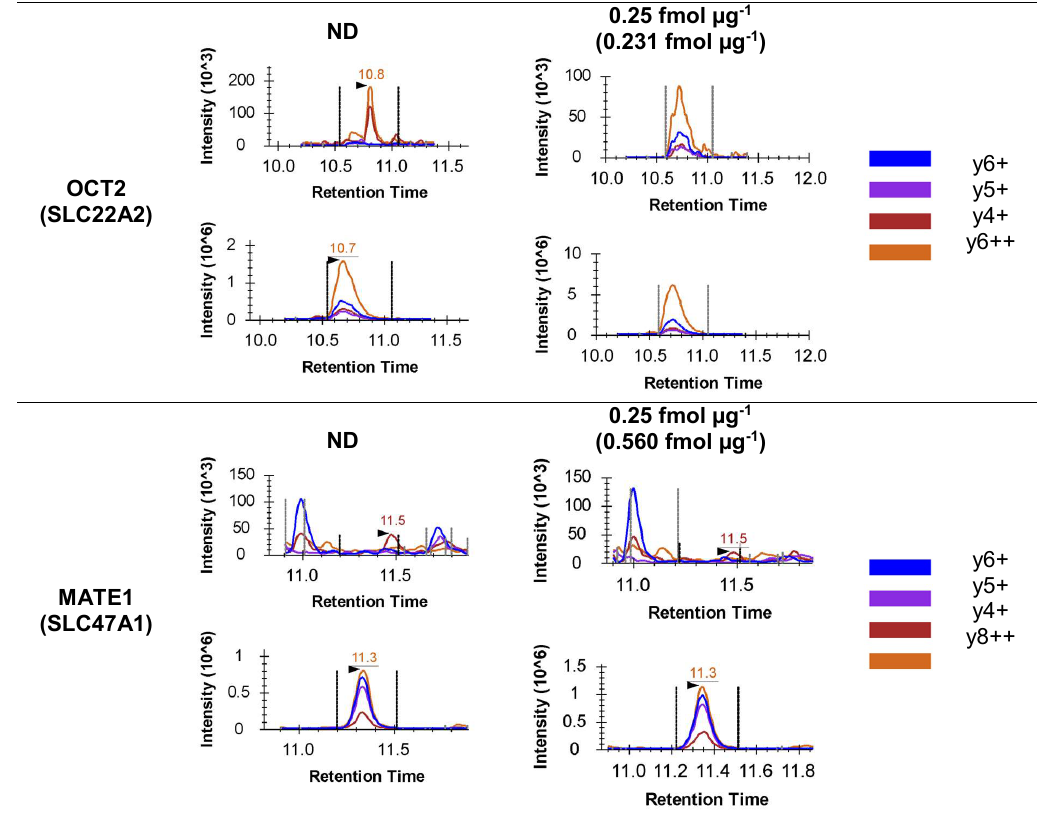
Figure 3. Representative chromatogram examples of the three quantified transporters OCT1 (SLC22A1), OCT2 (SLC22A2) and MATE1 (SLC47A1). The left column entitled “Vessels glioma3” shows the chromatograms obtained after analysis of the sample “Vessels glioma3”, for each of the proteins. In each box of this column, the top chromatogram is the one obtained after detection of the unlabeled peptide specific for the protein; the chromatogram at the bottom is the one obtained after detection of the labeled peptide. The absence of unlabeled peptide (therefore protein ND; not detected) is proven when there is no peak on the top chromatogram at the same retention time as the peak of the bottom chromatogram (case of OCT1, MATE1). For OCT2, the absence of the unlabeled peptide is proven because the peak at 10.8 min (top chromatogram) is the one obtained for a molecule which does not have the same relative intensity of the daughter ions (y6 + , y5 + , y4 + , y6 ++ ) as the one in the bottom chromatogram (labeled peptide). The column “Lowest calibration point” (low limit of quantification, LLOQ) shows chromatograms obtained for each proteotypic peptide of OCT1, OCT2 and MATE1, at two different concentrations; in each box 0.25 fmol µg −1 (top chromatogram) and the lowest point of the calibration curve (the nearest of the LLOQ) (bottom chromatogram). The “Legend” column shows the colors used to identify the daughter ions in the chromatograms. The relative intensity of these ions must be the same for the labeled peptide and the unlabeled peptide (if detected) to prove the presence of the proteotypic peptide (and therefore of the protein).